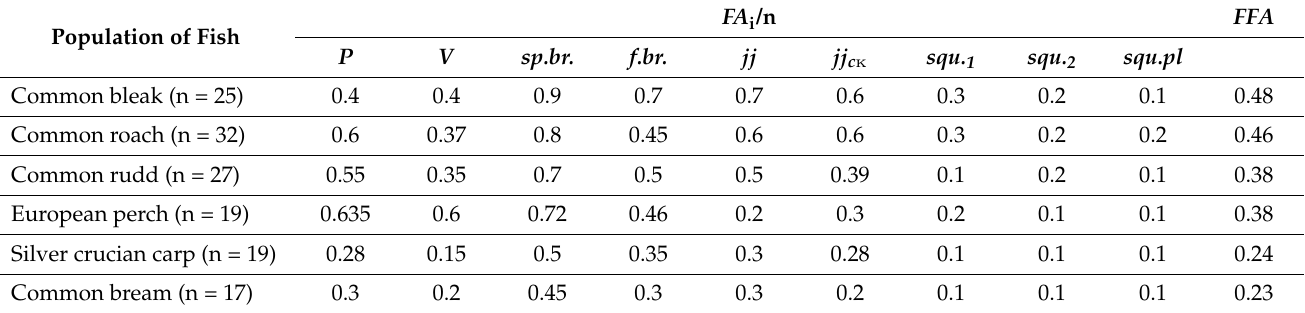
Table 7. The FFA for each studied fish population in the Ustya River at sampling site No. 5 ( p ≤ 0.05).